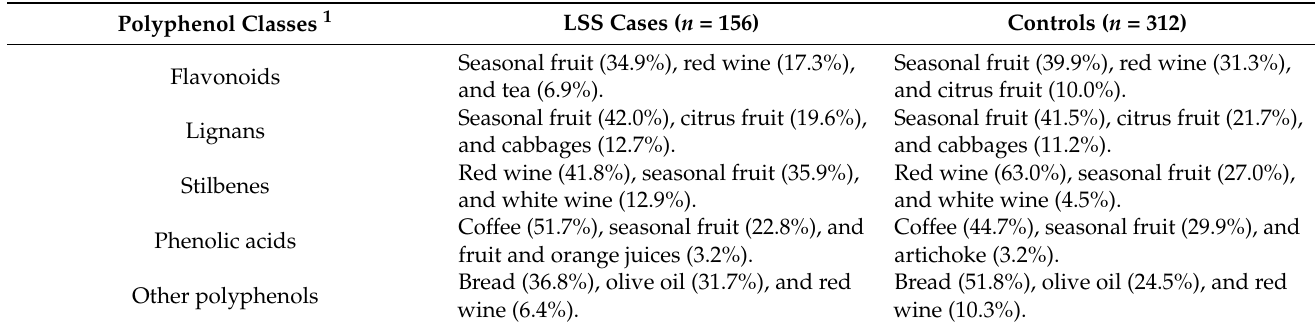
Table 3. Main food contributors to the intake of polyphenol classes in LSS cases and